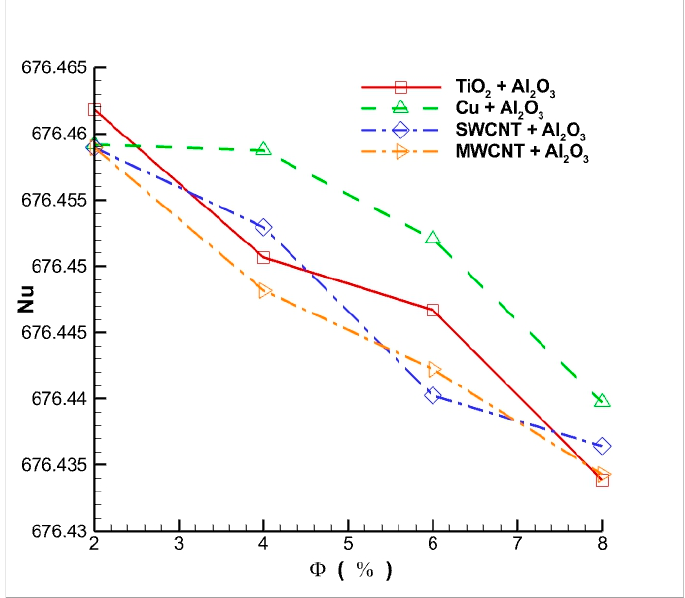
Figure 8. Variation of Nusselt Number with respect to volume fractions.